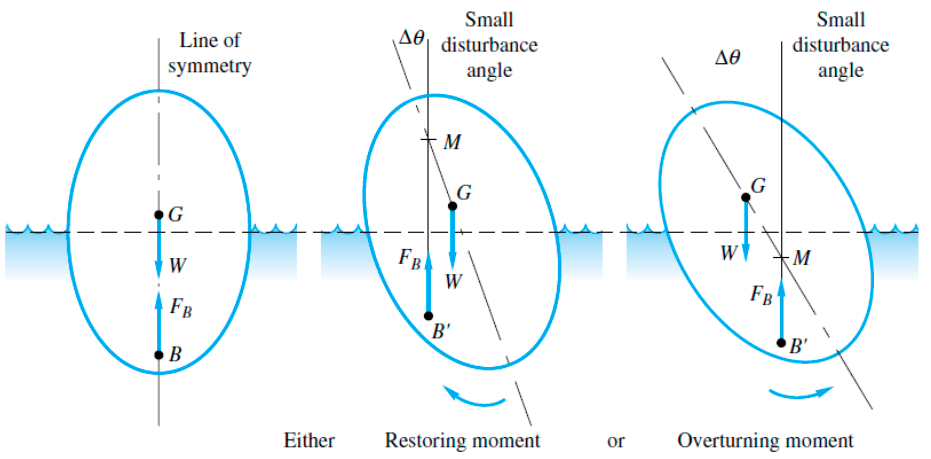
Figure 6. Calculation of the metacenter M of the floating body [32].